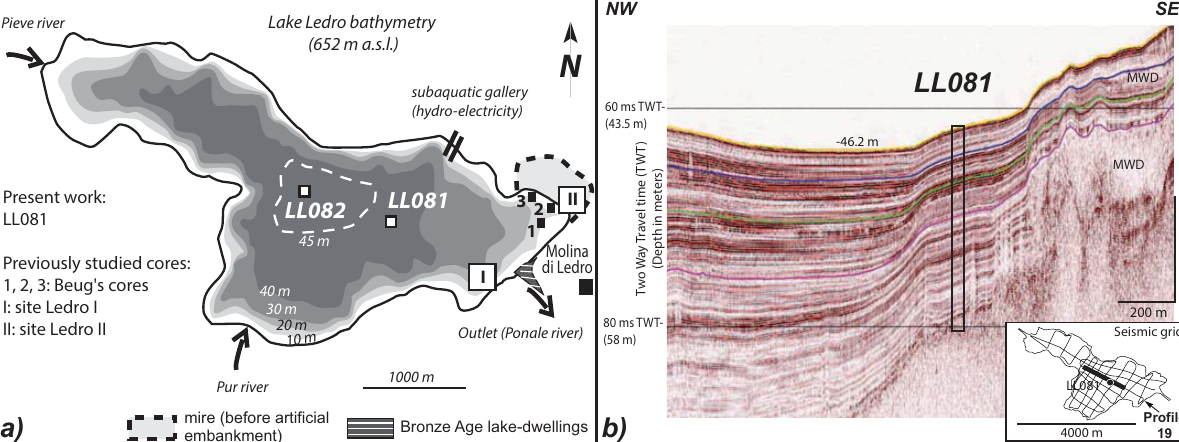
cover may have favoured a mineral magnetic increase